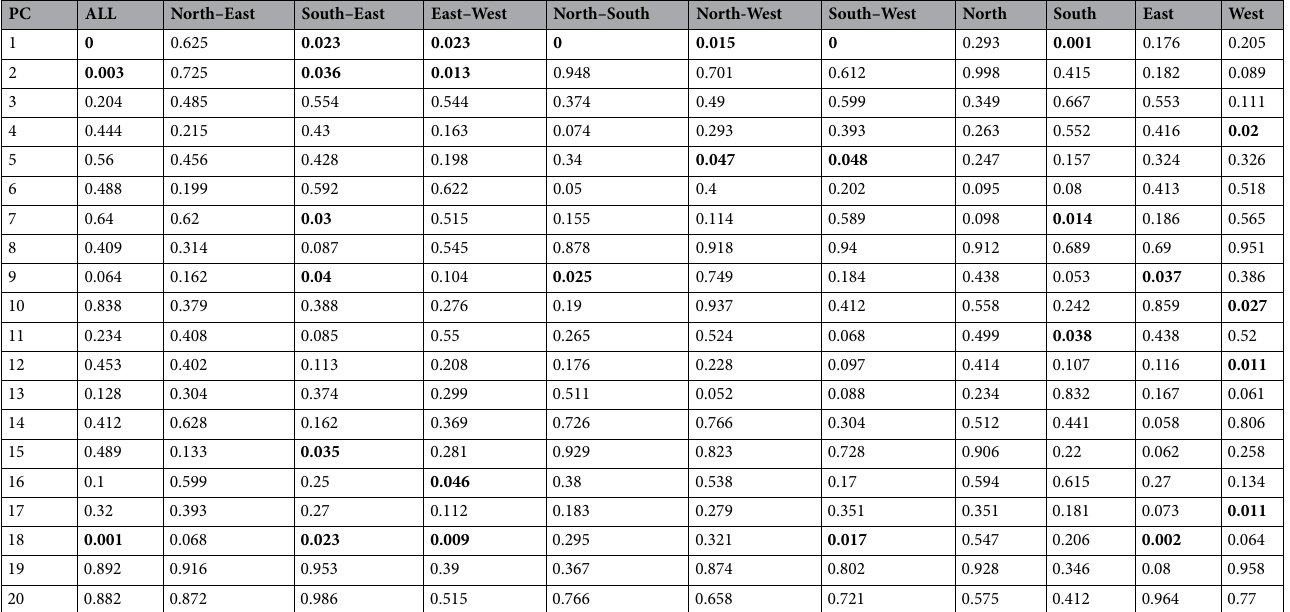
Table 2. Significance of genetic PC correction on facial phenotype. The table shows p-values from permutation (10,000 iterations) testing on segment 1 (entire face) for different input groups. Significant results (p-value < 0.05) are highlighted in